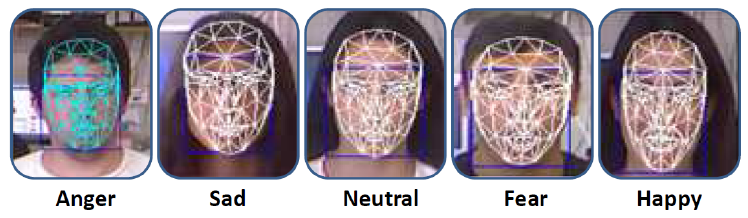
Figure 17. Sample of users in the tests described in this